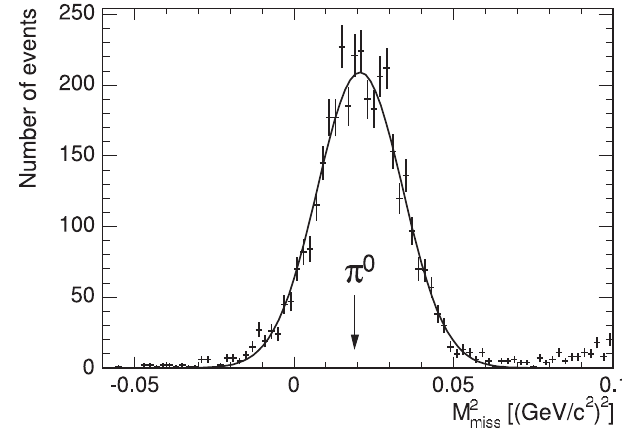
peak.FIG. 6. Correlation of the measured time difference (cid:1) t (cid:1) ~p (cid:2) ), assuming that the particle tracks ; ~p the calculated (cid:1) t tof 1 2 correspond to protons.